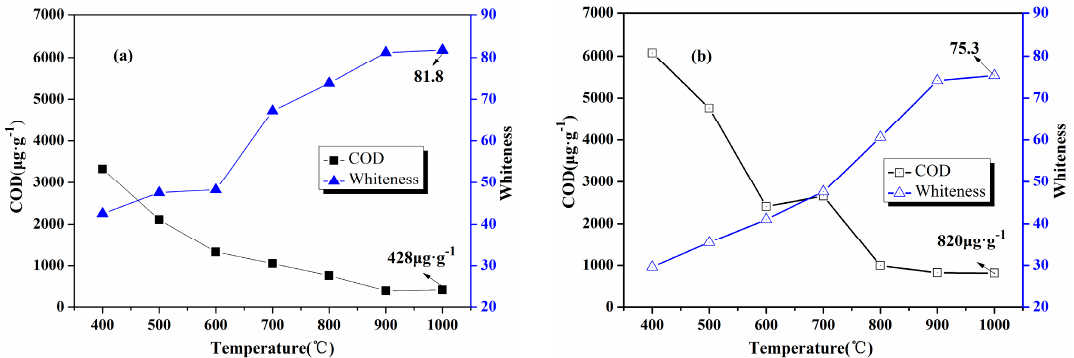
Figure 7. Chemical oxygen demand ( COD) and whiteness of calcined products by fluidized calcination ( a ) and static calcination ( b ) at various temperatures.